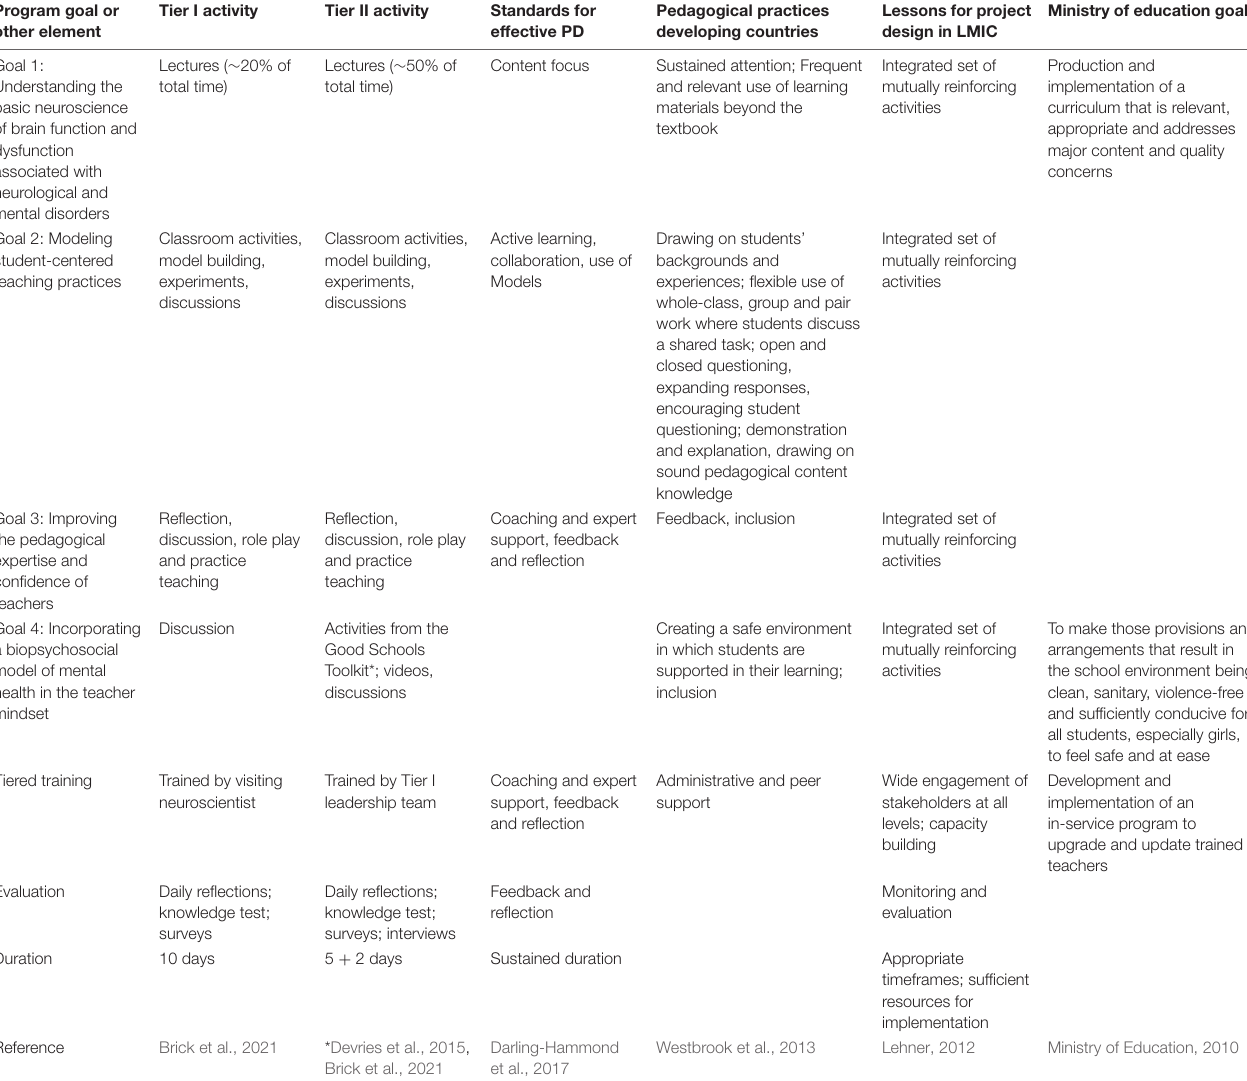
TABLE 1 | Alignment of program goals and elements with various